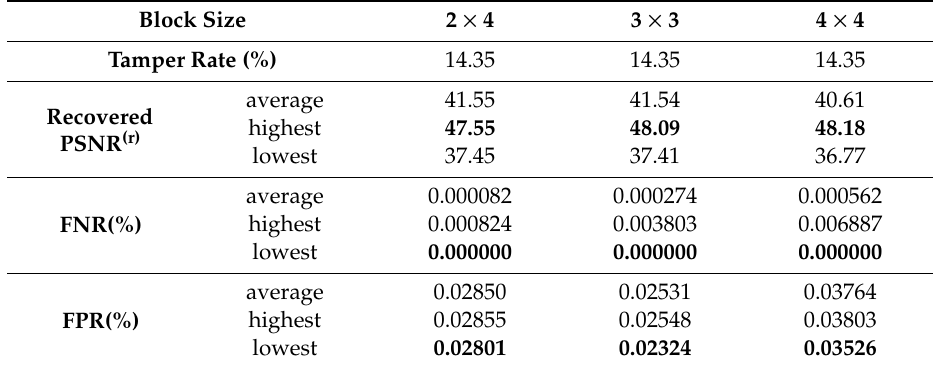
Table 8. Recovered PSNR, FPR, and FNR results of the proposed method (block-wise) using 500 test images under the tamper rate of 14.35% with variant block sizes.